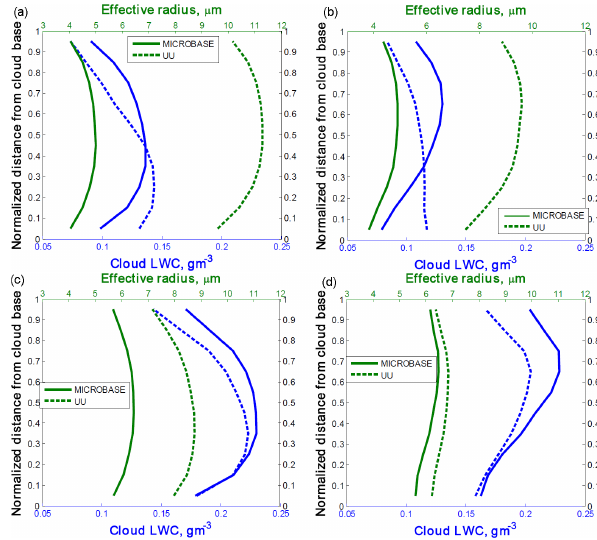
normalized height from cloud base for the period of 1998 to 2006. Solid and dashed lines indicate respectively MICROBASE and UU retrievals, while green and blue colors represents r e and LWC. (a) all clouds; (b) columns without raining layers; (c) columns with- out mixed-phase layers; and (d) columns without raining or mixed- phase